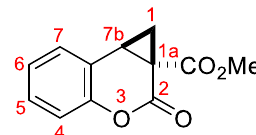
Figure 1. Atom numbering in compounds 2 .